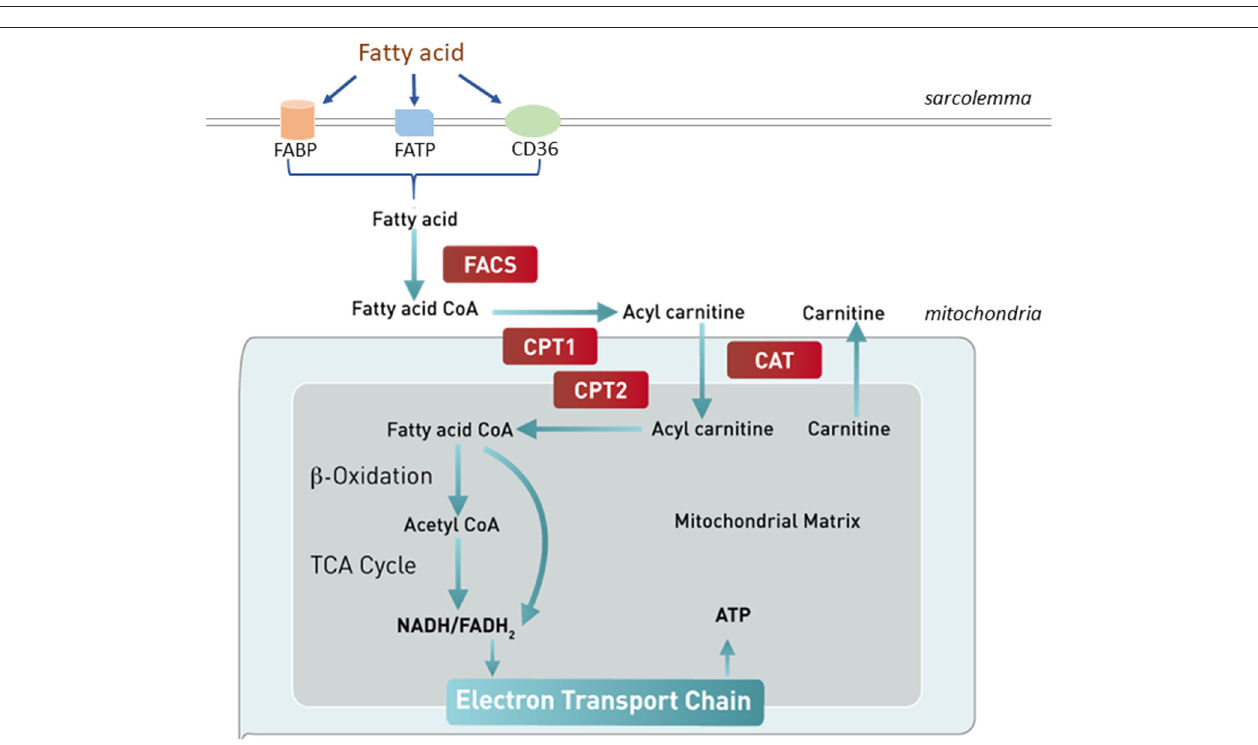
FIGURE 2 | Fatty acid uptake and oxidation. Free fatty acids in circulation enter the cardiomyocytes through either passive diffusion or a carrier protein-facilitated pathway, which involves fatty acid binding protein (FABP), fatty acid translocase (CD36/FAT), or fatty acid transporter protein (FATP). Cytosolic fatty acids are esterified to become fatty acyl CoA by fatty acyl CoA synthase (FACS). The acyl group of fatty acyl-CoA is transferred to carnitine to form acylcarnitine by carnitine palmitoyltransferase 1 (CPT1). The acylcarnitine enters the mitochondrial inner matrix via the carnitine shuttle and is converted to fatty acyl CoA by CPT2. The fatty acyl CoA goes through several cycles of β -oxidation producing NADH, FADH 2 , and acetyl CoA, which enters the TCA cycle for ATP production. CAT, carnitine translocase.